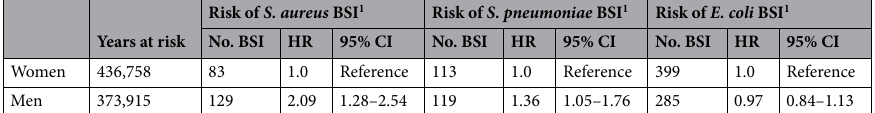
Table 3. Associations of sex with risk of bloodstream infections caused by the most common bacteria. BSI bloodstream infection, HRs hazard ratios, 95% CI 95% confidence intervals. 1 Cox regression analyses were adjusted for age as the underlying